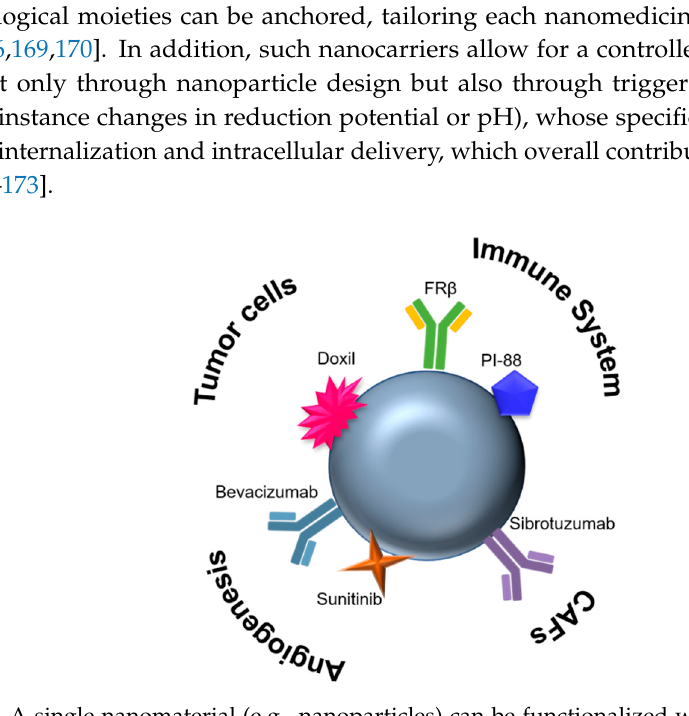
Figure 3. A single nanomaterial (e.g., nanoparticles) can be functionalized with different moieties to target different cell populations in the TME (tumor and stromal cells), enabling a combined strategy for cancer therapeutics. CAFs, Cancer-associated fibroblasts; FR β , folate-receptor beta; PI-88, Phosphomanno-pentose sulfate.